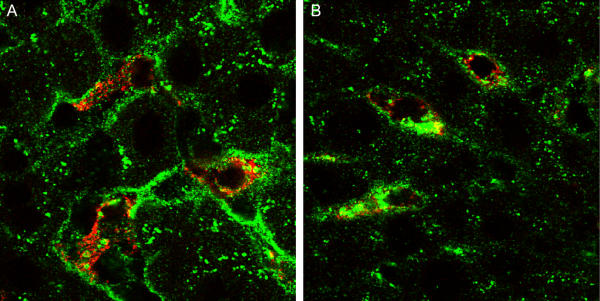
Higher magnification of sections from the same experiment as in Figure 2 Both sections are 15 min after injection of active bovine LPL. The rat in panel A did not receive heparin; the rat in panel B had been given heparin five min before LPL. Green colour represents staining of LPL by the rabbit polyclonal antibody. Red colour represents staining of Kupffer cells by the ED2 antibody. The magnification was × 60 + zooming.